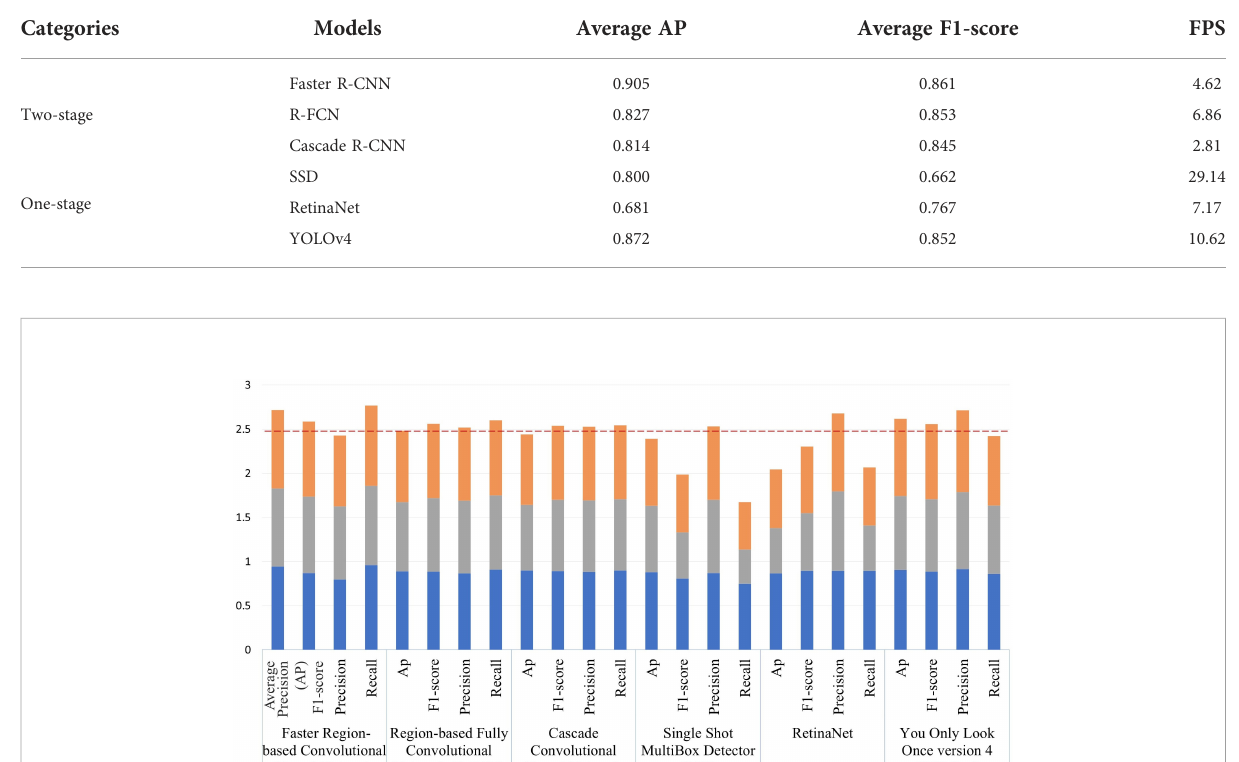
TABLE 4 Accurcies and speed of different models.